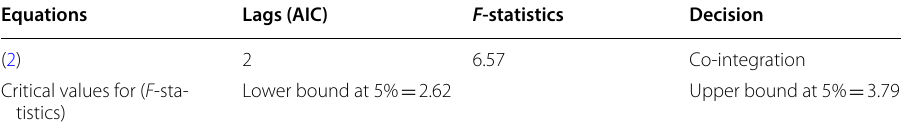
Table 2 Bounds test to co-integration